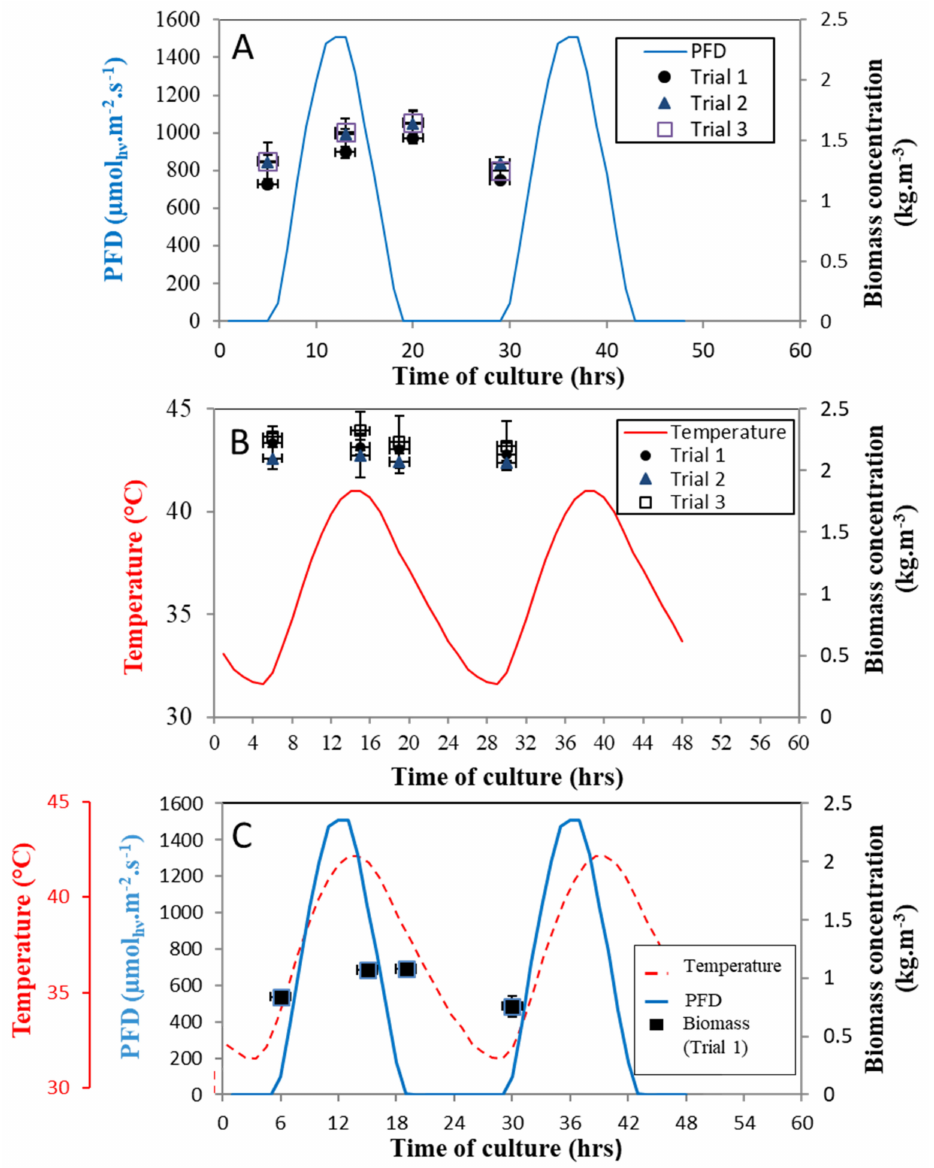
Figure 5. Evolution of biomass concentration of N . sp. QU130 under three different cultivation regimes: ( A ): Cultivation under day/night cycles (Experiment C); ( B ): Cultivation under temperature fluctuation (Experiment B) and ( C ): Cultivation under combined light and temperature cultivation (Experiment D). Measurements taken in triplicates on 3 different days in the steady-state culture (only Trial 1 is shown in Figure 5c—similar results for other